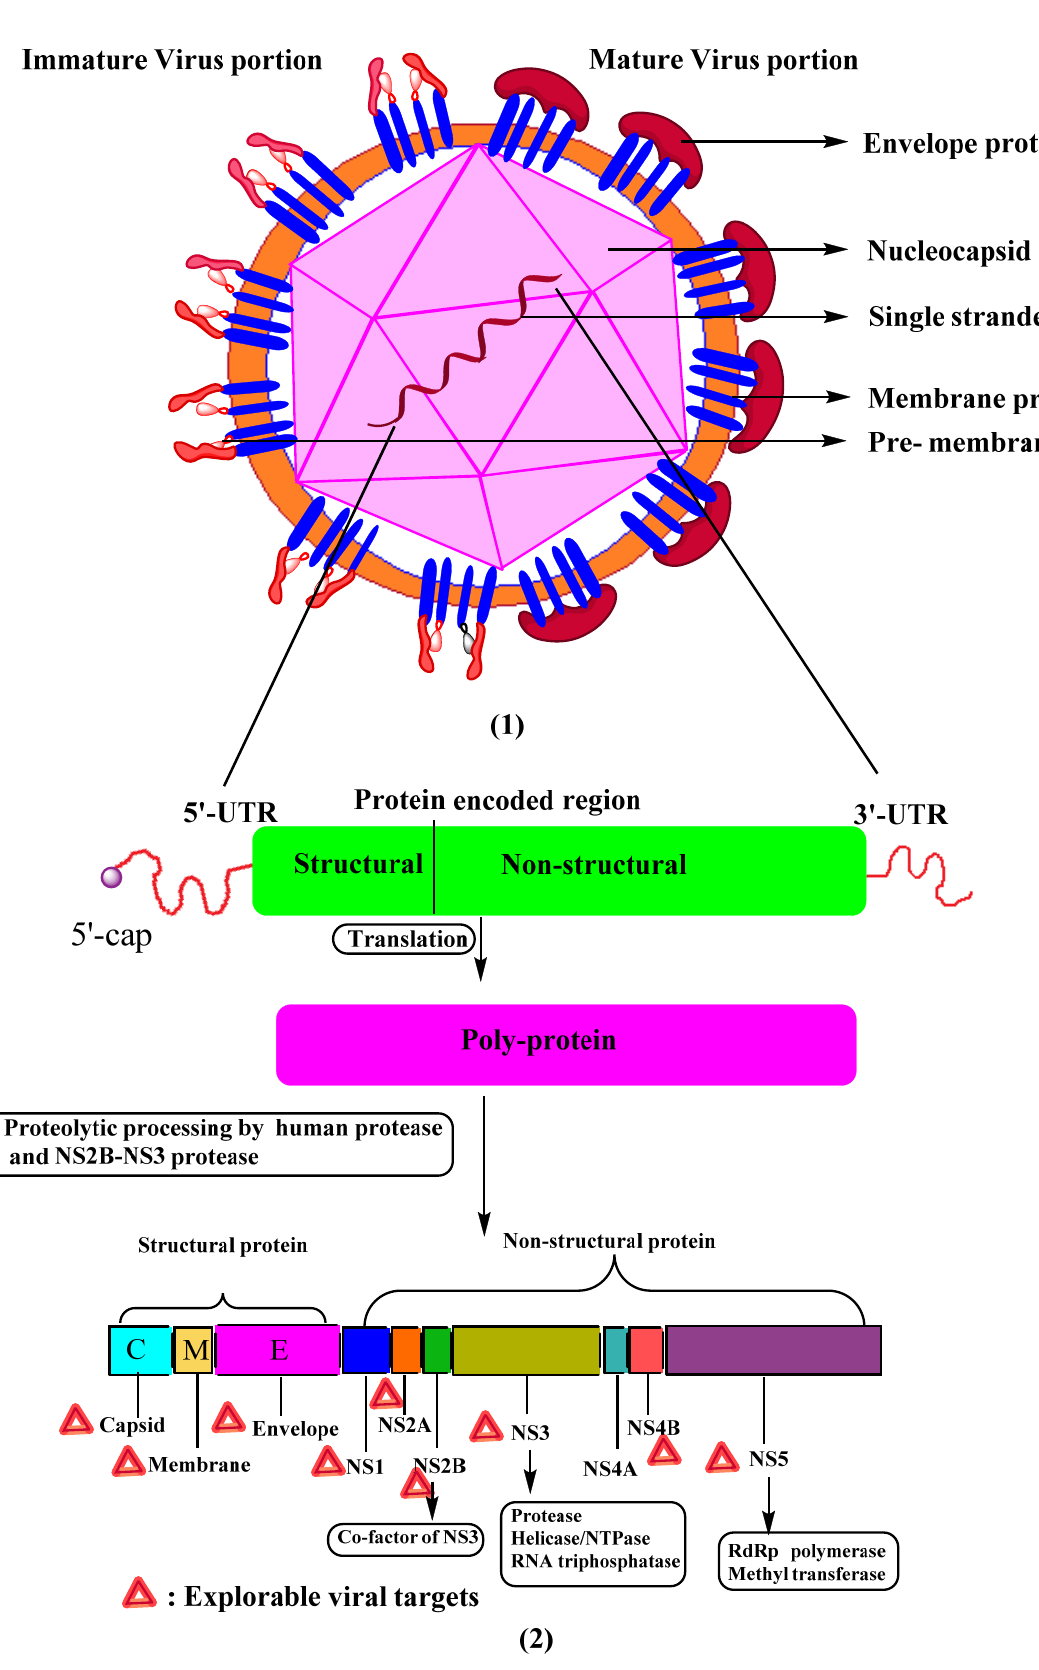
Figure 1. Schematic diagram showing ( 1 ) structure of dengue virus, mature, and immature viral portion difference. ( 2 ) DENV RNA genome and polyprotein processing to form three structural and seven non-structural proteins. UTR—untranslated region.